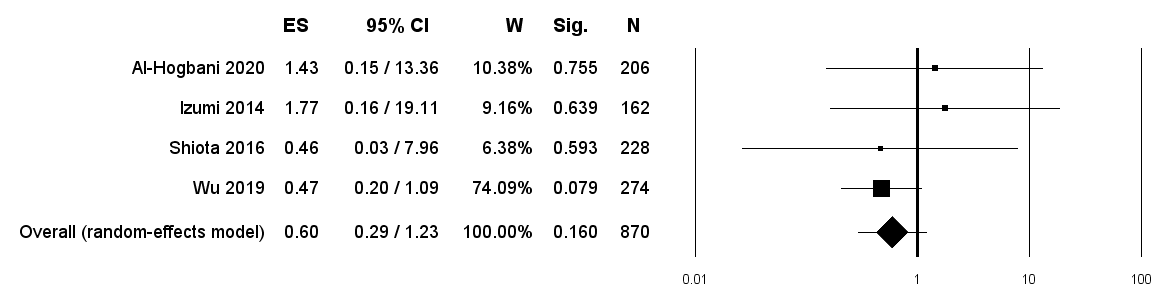
Figure 5. Forest plot showing the association between use of 5-ARIs or ADT and the RR of BCa progression. ES: Effect Size; CI: Confidence Interval. (I 2 = 0.00, p = 0.633).